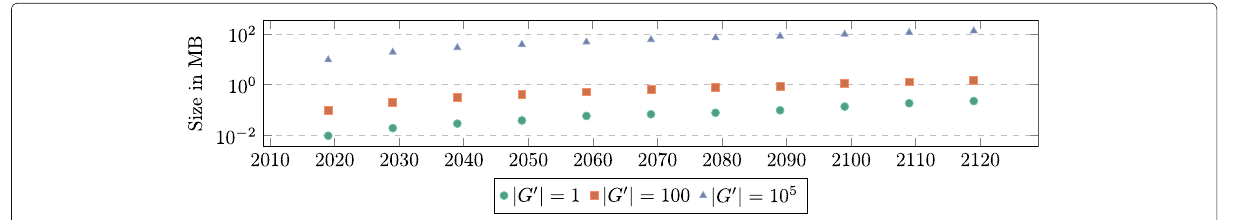
Fig. 3 Size of partial integrity proof for partial genome data G (cid:4)